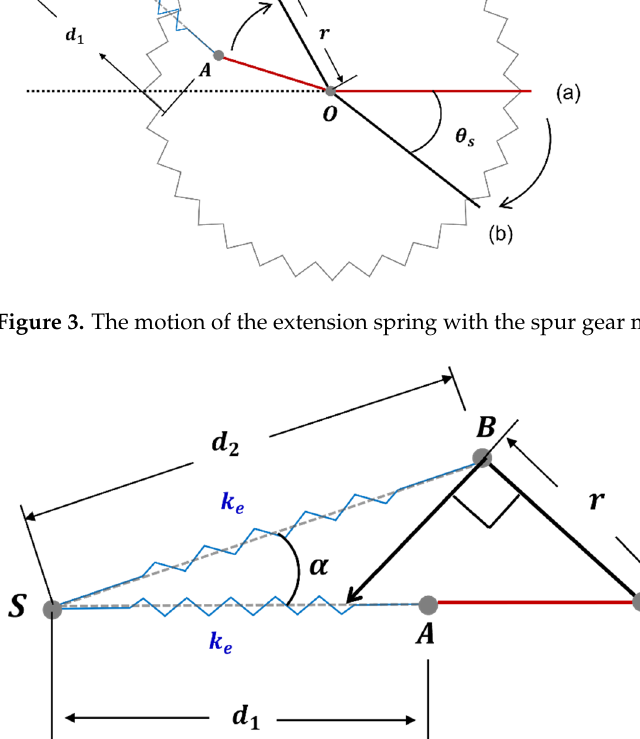
Figure 5. Spring torque with wing rotation angle. By stretching the extension spring at the zero position by moving away the fixing point to the body frame, tension can be provided, even when the wing is at zero position. In this case, the spring torque at low wing angle range is increased, compared with the toque increase in higher angle range, and thus the rotational elastic constant is linearized. Denoting the increased distance offset as 𝑑̅ , Equation (7) is modified into Equation (8). The red line in Figure 5 shows that when the offset distance 𝑑 ̅ is given, the effective torque with wing rotation becomes more linear. Here, the 𝑑̅ is fixed as 2.4 mm. 𝜏 (cid:3032)(cid:3046) (cid:3404) 𝑘 (cid:3032) (cid:4666)𝑑 (cid:2870) (cid:3397) 𝑑̅ (cid:3398) 𝑑 (cid:2869) (cid:4667) (cid:3400) cos (cid:4666)𝜋 2 (cid:3398) (cid:4666)𝜃 (cid:3046) (cid:3397) 𝛼(cid:4667)(cid:4667) (cid:3400) 𝑟 (8) With the given 𝑑̅ and using root mean square method, the rotational elastic constant 𝑘 (cid:3045) is obtained as 0.01954 N ∙ mm/rad, and the correlation factor is 0.9965. The number of teeth of pinion gear and spur gear are 7 and 81, respectively. The moment of inertia of all of the rotating components, which is computed by CATIA simulation program, is 7.53 × 10 − 8 g ∙ m 2 . Therefore, the natural frequency of the whole flapping system is around 22 Hz, as calculated from Equation (6) with the given parameters 𝑘 (cid:3032) and 𝑛 . 3. Prototype Flapping Winged Robot